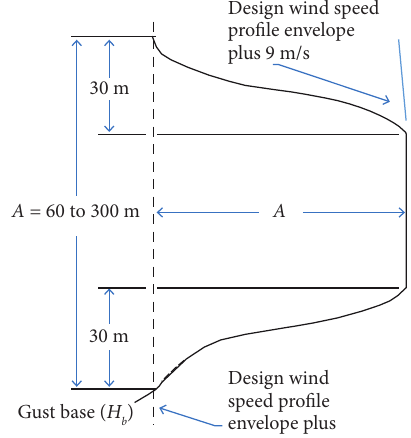
Figure 2. Example of a discrete gust model (quasi-square-wave shape) (Johnson,